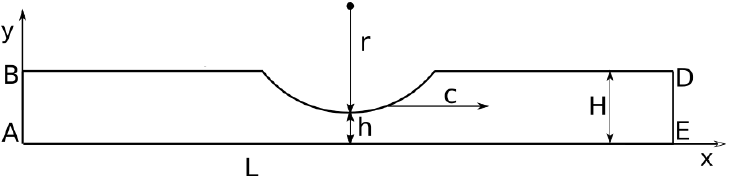
Figure 1. Geometry of the two-dimensional computational domain for the peristaltic pump. Mir- roring this scheme with respect to the x -axis and extruding with respect to the z -axis provides the geometry of the full